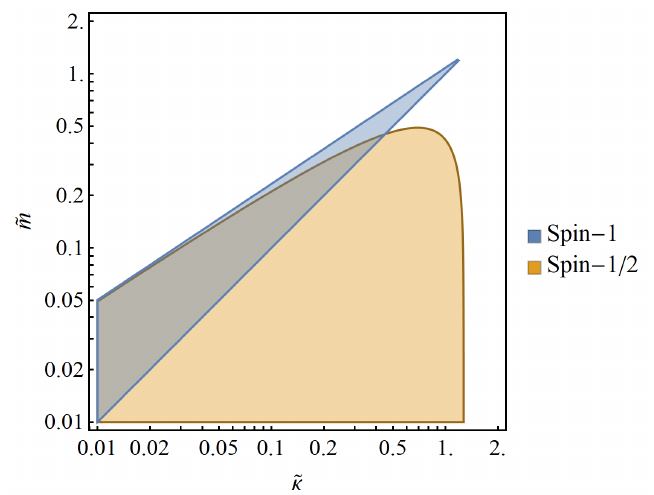
Figure 21 . The parameter region where the Ginzburg criterion (4.70) is satisfied. The blue region stands for spin-1 bosons while the yellow region stands for spin-1/2